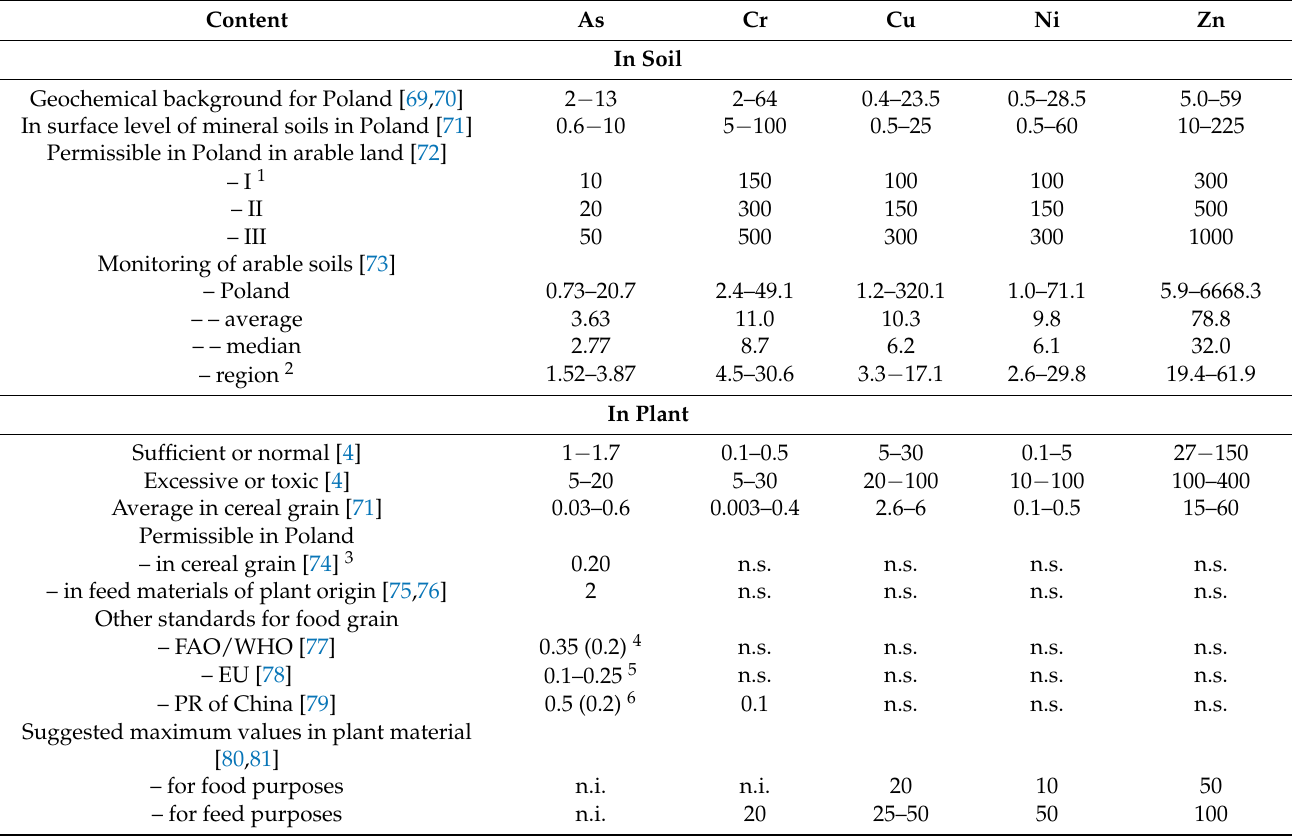
Table 7. Reference values for PTE of the soil and plants, mg · kg − 1